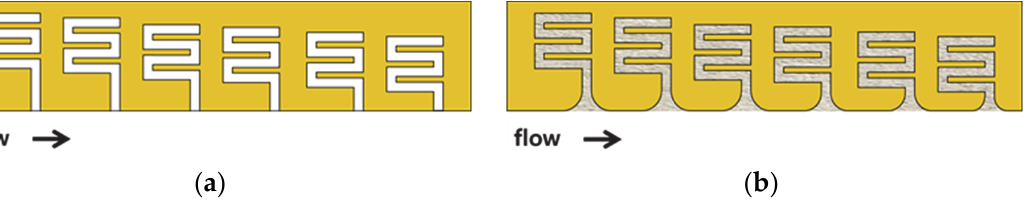
Figure 8. Metasurface model of the metasilencer: ( a ) without consideration of flow; ( b ) with consid- eration of flow.